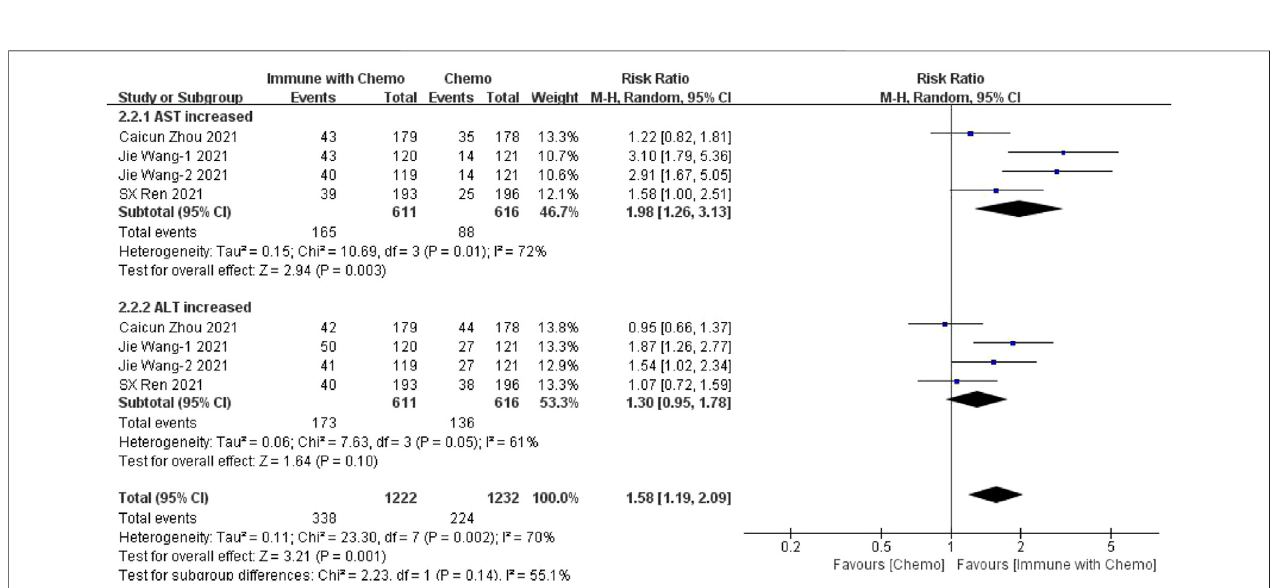
FIGURE 5 | Meta-analysis results of adverse reactions of any grade in hepatotoxicity between the chemo with immune group and chemo group.